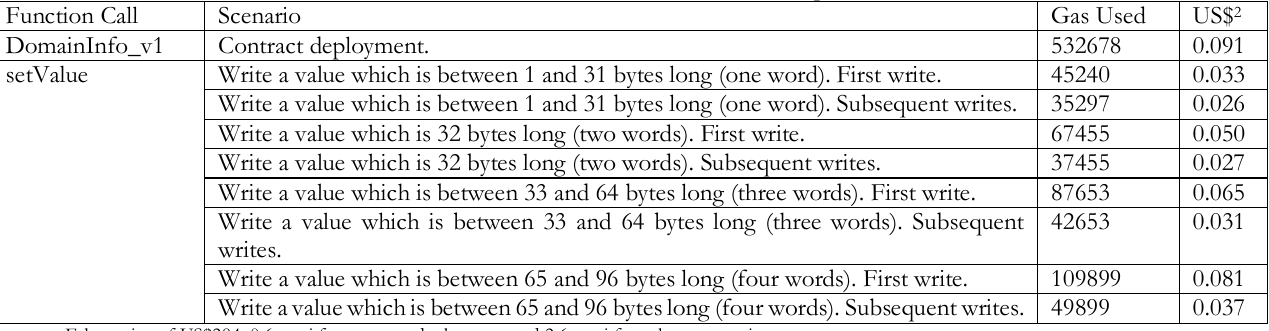
Table 2. Gas cost for calls to DomainInfo_v1.sol